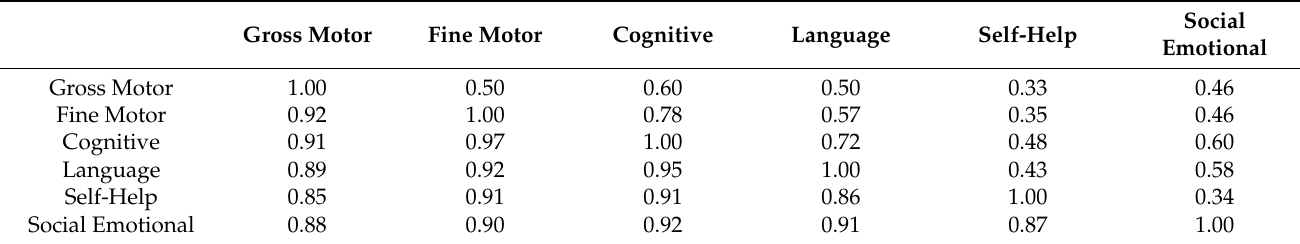
Table 9. Zero-order correlations and partial correlations, controlled for age, among the C-LAP’s six domains among participants from other provinces between 2016 and